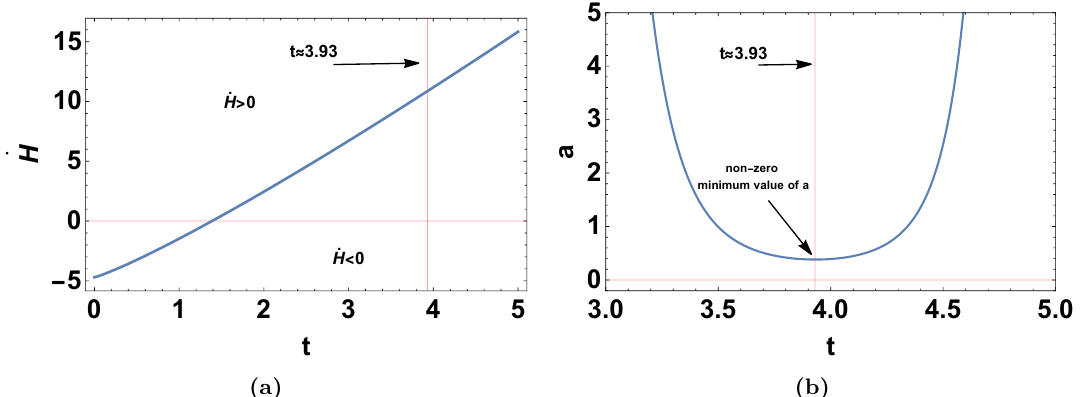
Figure 2. Evolution of the time derivative of the Hubble parameter H and that of the scale factor a as a function of the cosmic time t .